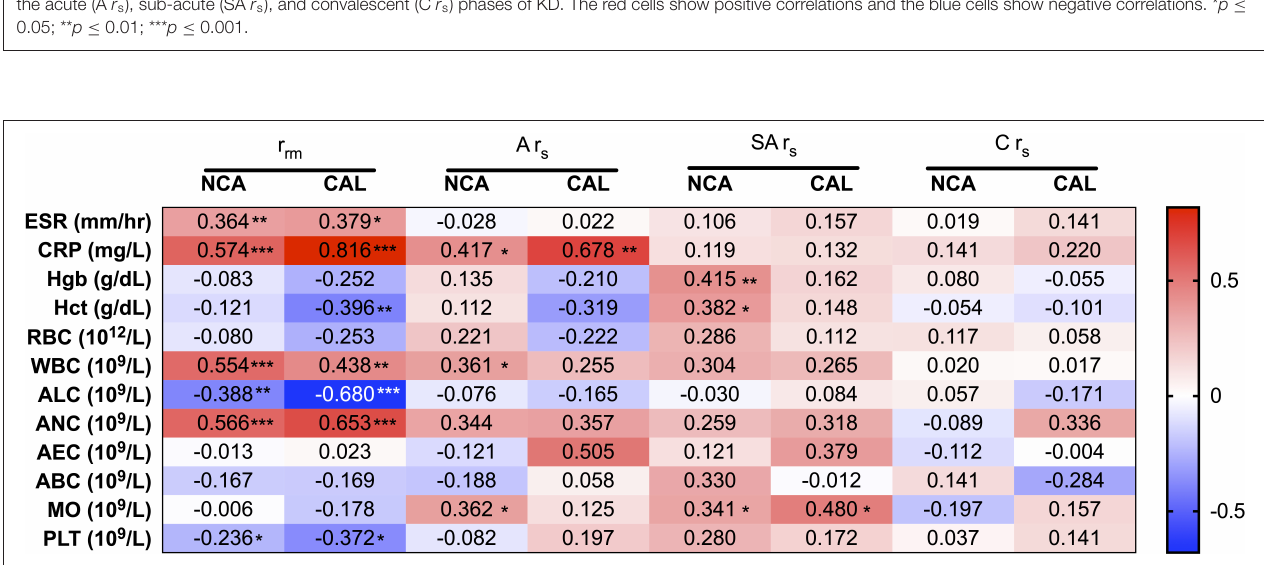
FIGURE 4 | Correlations between PTX-3 and the clinical laboratory parameters of inflammation (i.e., C-reactive protein, erythrocyte sedimentation rate, and complete blood count) stratified by normal coronary artery (z-score < 2.5) and coronary artery lesion (z-score ≥ 2.5) groups. The number in each cell in the heat map indicates the repeated-measures correlation ( r rm ) analysis between PTX-3 and the clinical assessment of inflammation at all phases of Kawasaki disease (KD) and Spearman’s correlation ( r s ) analysis between PTX-3 and the clinical laboratory parameters of inflammation at the acute (A r s ), sub-acute (SA r s ), and convalescent (C r s ) phases of KD. The red cells show positive correlations and the blue cells show negative correlations. * p ≤ 0.05; ** p ≤ 0.01; *** p ≤ 0.001.